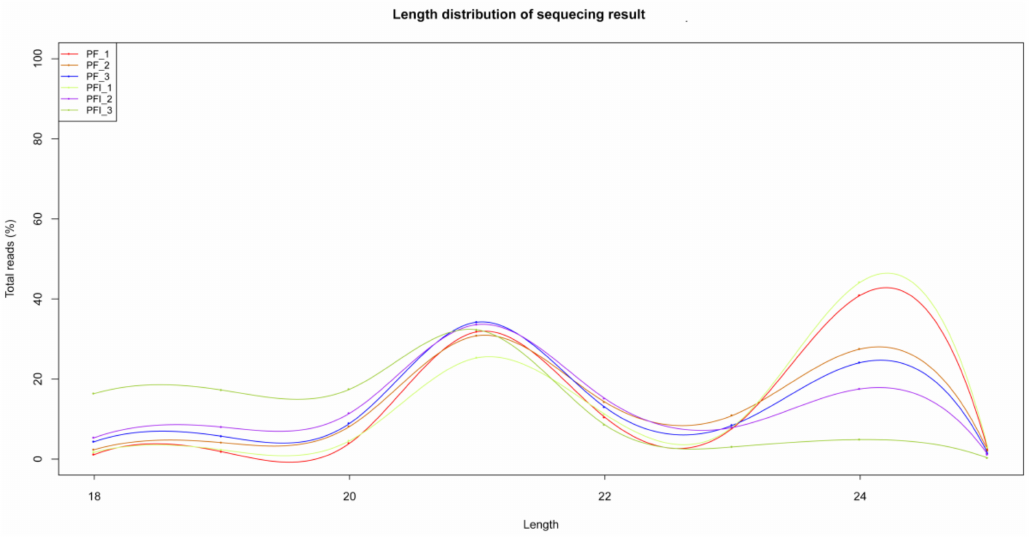
Figure 3. Length distribution of small RNA